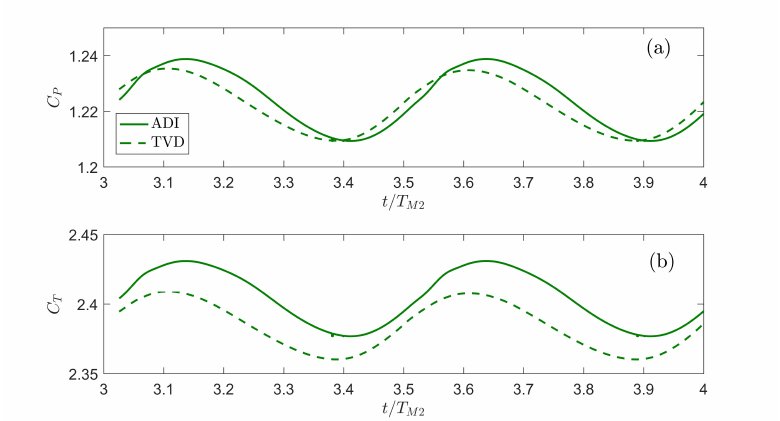
Figure 3. Time-series of C P ( a ) and C T ( b ) coefficients obtained from alternating direction implicit (ADI) (continuous-line) and total variation diminishing (TVD) (dash-line) schemes for B =